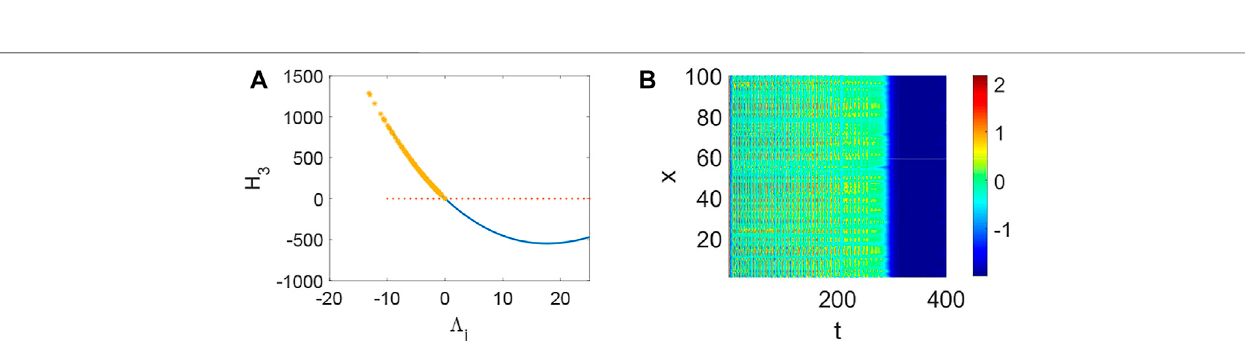
Frontiers in Physiology |